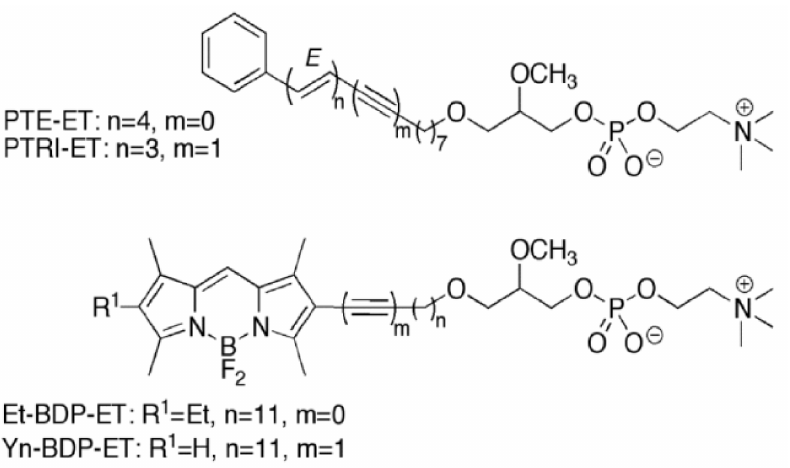
Figure 6. Chemical structures of fluorescent edelfosine